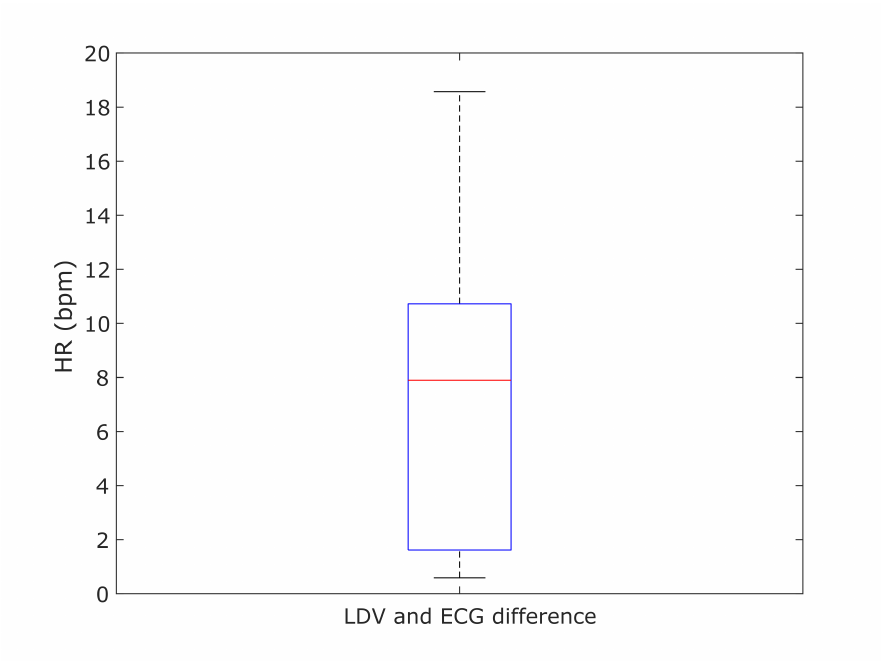
Figure 12. Boxplot of the absolute differences between the mean value of the heart rate (HR) computed with the LDV and the ECG in the 28